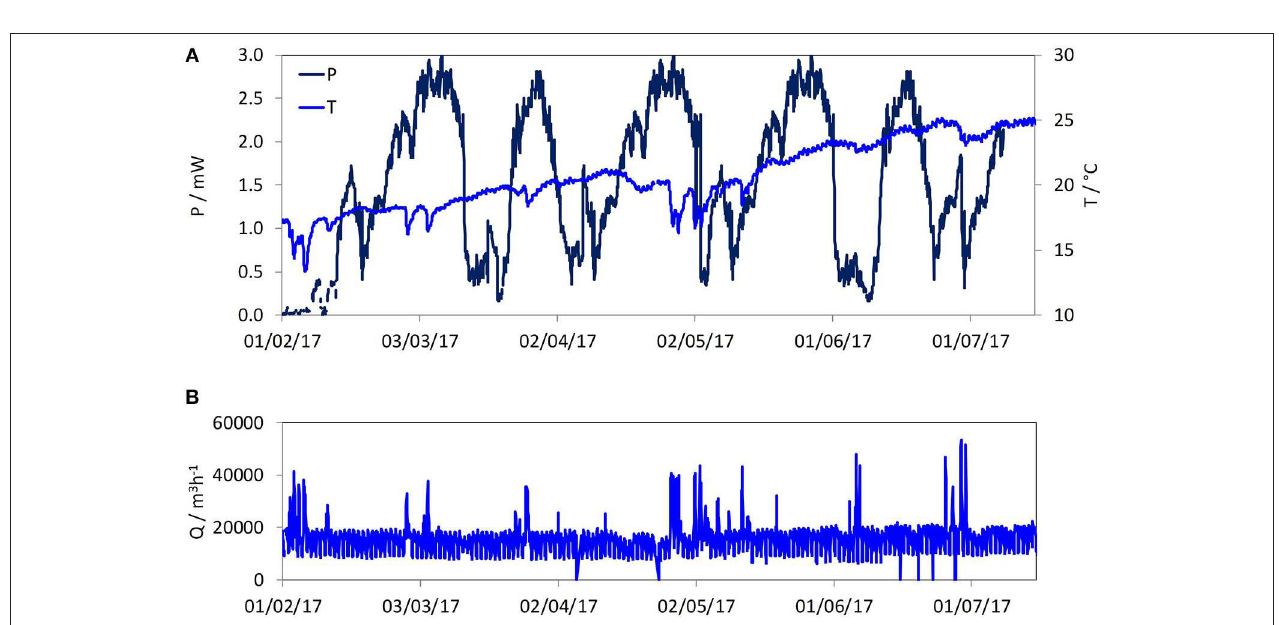
FIGURE 3 | Power trend of the Flat-large MFC (50 × 50cm) operated from January to July 2017 (Milano-Nosedo WWTP) (A) ; trends of temperature and incoming wastewater flow in the plant (B) .